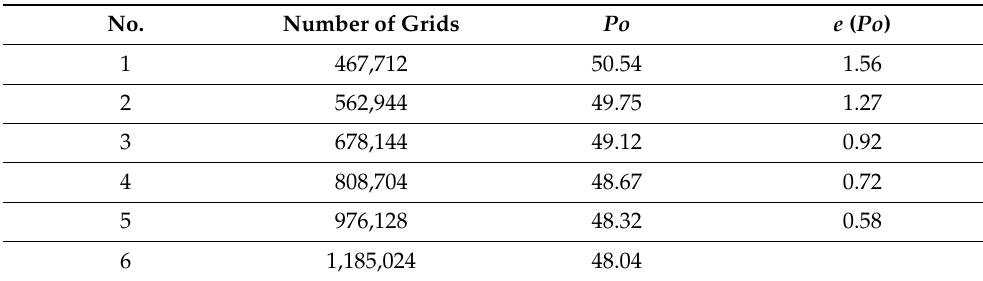
Table 3. Mesh-independent validation.